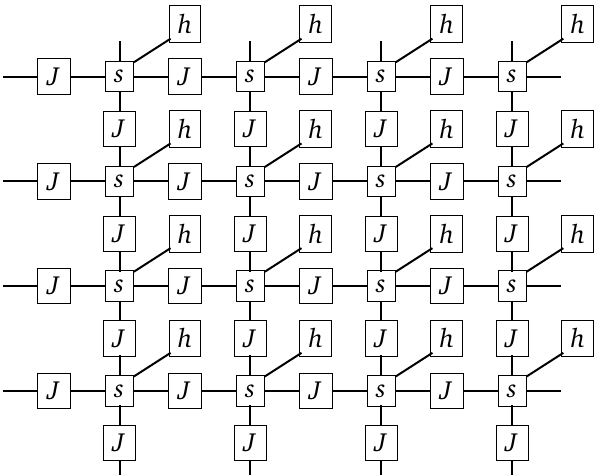
Figure 23: The 2D Ising model partition function is shown as a tensor network on a 4 × 4 periodic square lattice. The tensors labeled h and J are the same as in Figure 19, and the tensors labeled s are rank 5 Kronecker delta tensors. Note that the system wraps around its edges in a toroidal fashion, so there are actually no external